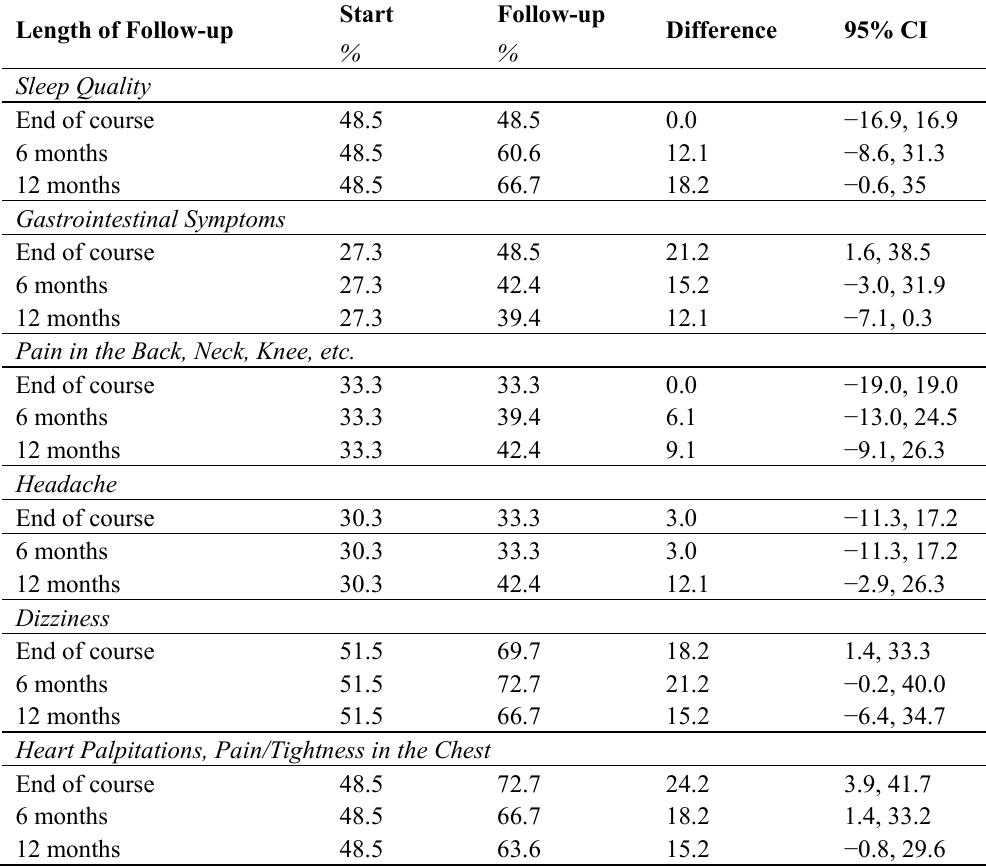
Table 6. Differences in paired proportions with 95% confidence interval (CI) for participants reporting absence of the respective stress-related symptoms. Comparing start of course with follow-up at course end as well as at 6- and 12-month follow-up, respectively (n =